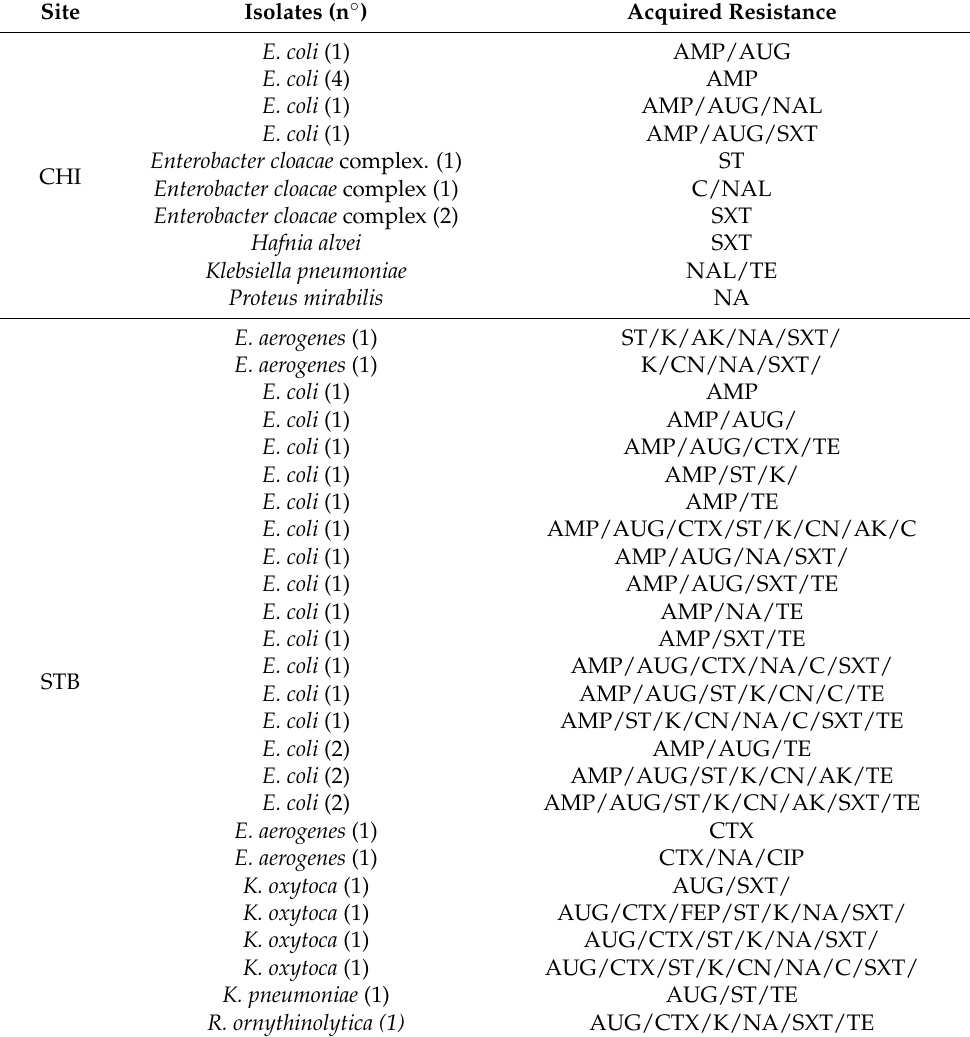
Table 2. Acquired resistance profiles of the rare antibiotic resistant